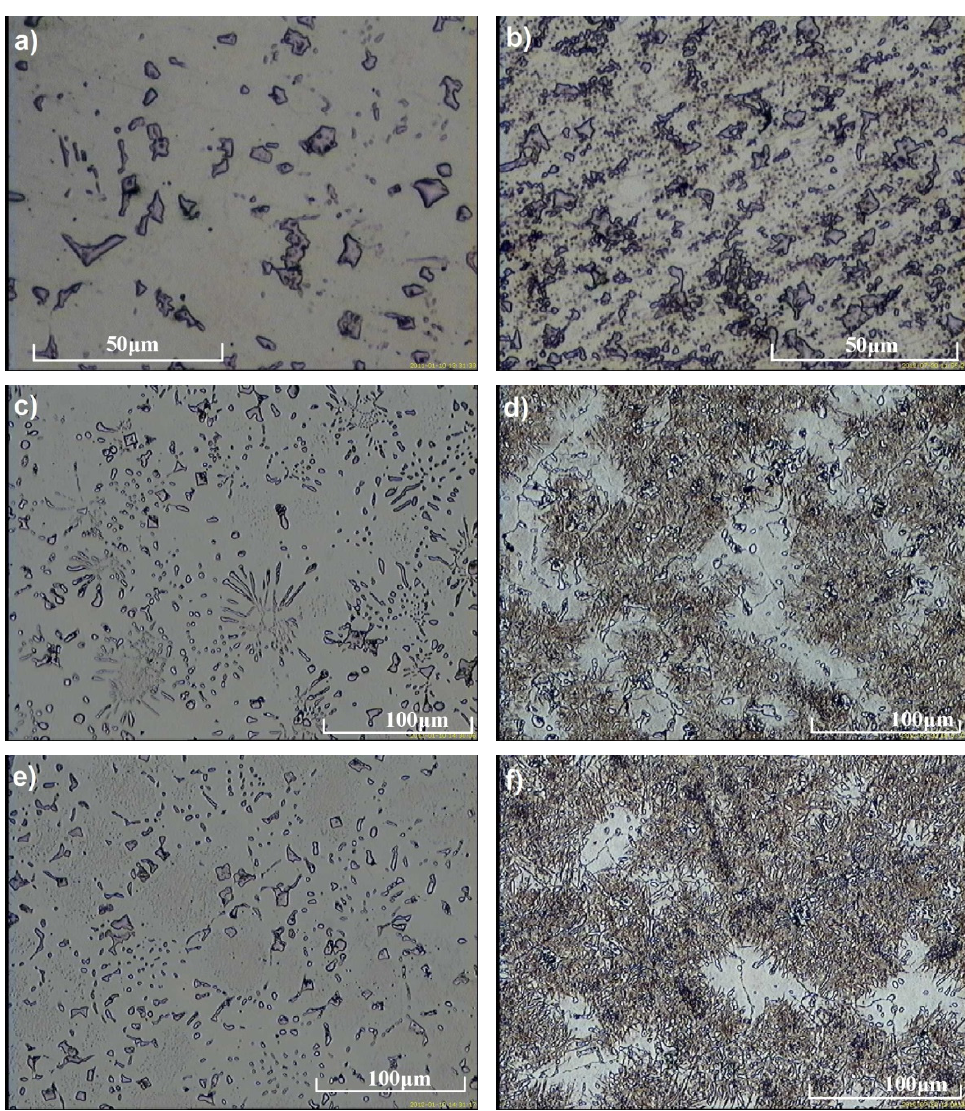
Figure 5. Microstructure of the tested alloys containing: ( a , b ) 5.5% V; ( c , d ) 6.3% V; and ( e , f ) 8.1% V after heat treatment. ( a , c , e ) unetched specimens; primary and eutectic vanadium carbides evenly distributed in alloy matrix. ( b , d , f ) specimens etched with nital; bright austenite, dark martensite, primary and eutectic vanadium carbides evenly distributed in alloy matrix.